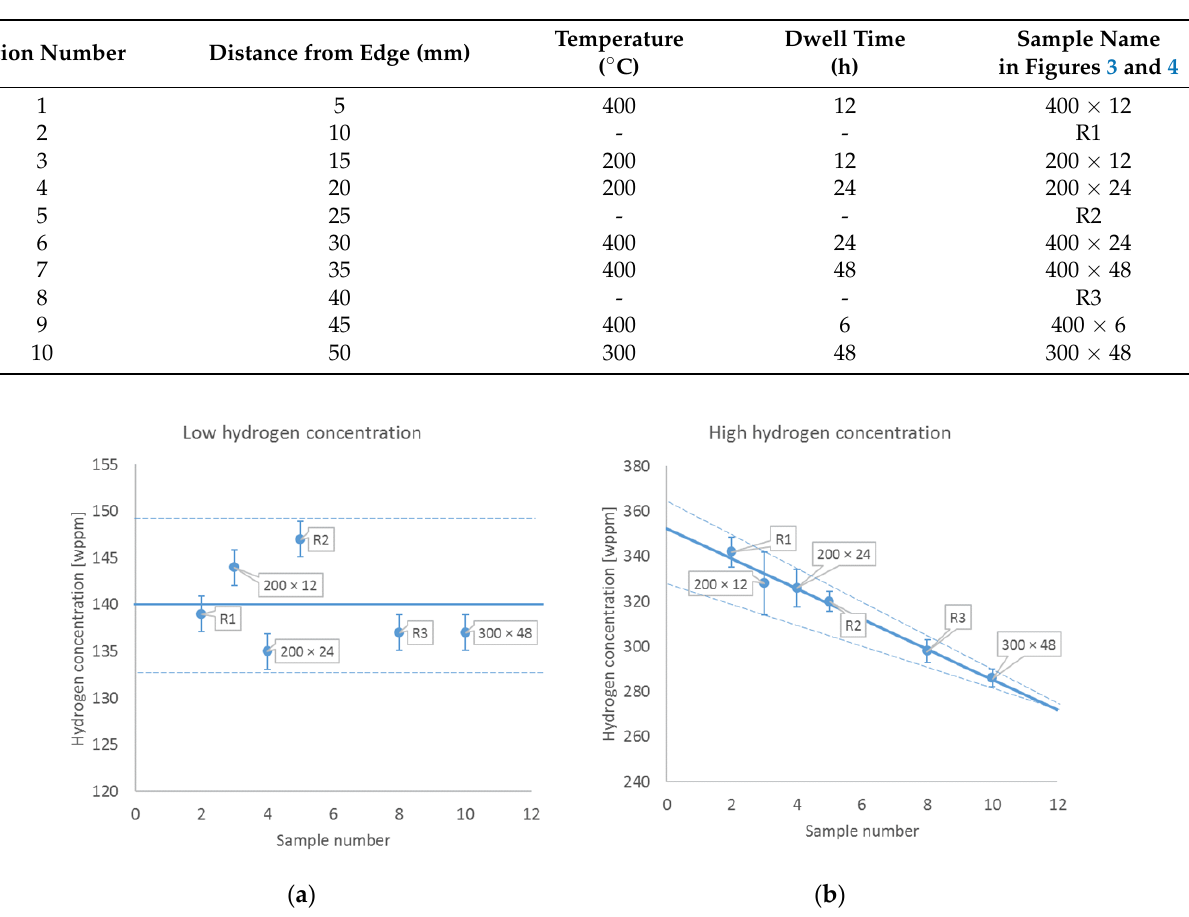
Figure 3. Hydrogen concentration measured in low ( a ) and high ( b ) hydrogen content cladding tubes. The dashed lines indicate upper and lower bounds, and the solid lines show the hydrogen concentration used as a target during hydrogen charging. The error bars correspond to the experi- mental uncertainty of the HVE measurements, equal to the highest between the uncertainty of the measurement due to the standard deviation in the hydrogen content of the calibration pins and the standard deviation among the three homologues sections of the measured rings.